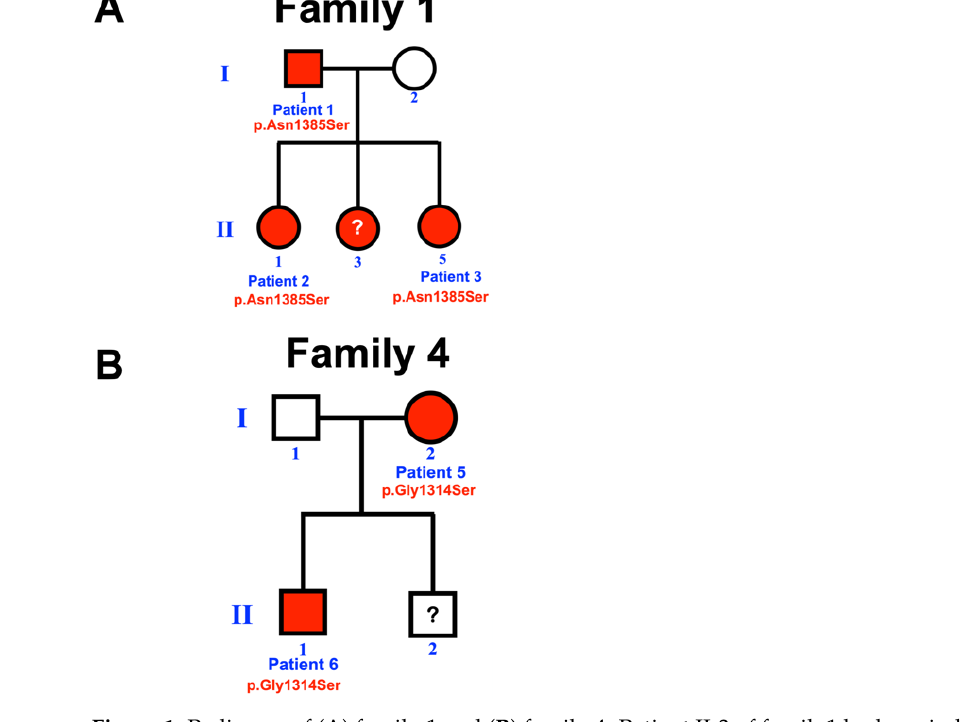
Figure 1. Pedigrees of ( A ) family 1 and ( B ) family 4. Patient II-3 of family1 had mesiodens but not available for genetic study. Patient II-2 of family 4 is not available for study.